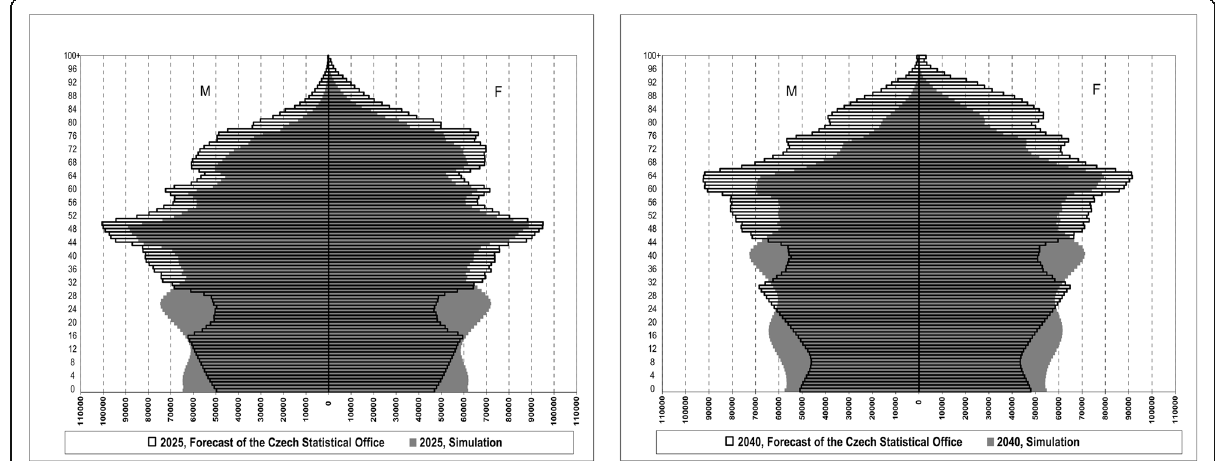
Fig. 6 Age structure of the Czech Republic — simulation versus official forecast. Source: [18], authors ’ calculations